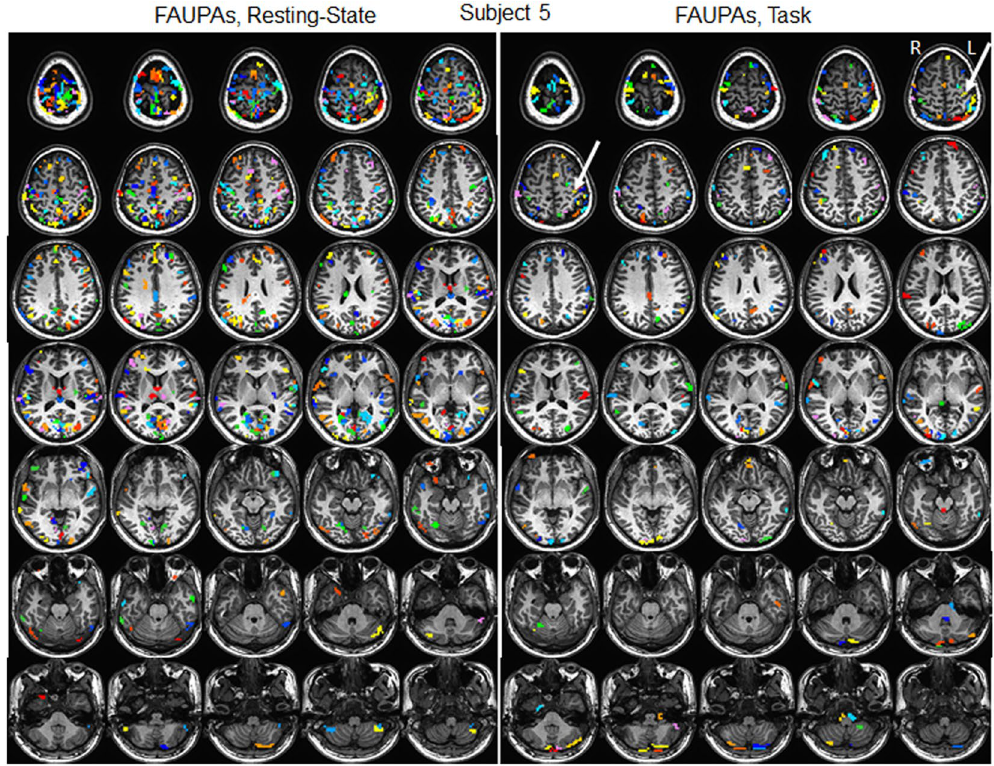
Figure 1. Illustration of FAUPAs for subject 5 (Table 1). Each colored cluster with all connected voxels of the same color represents a FAUPA, and a total of 16 colors are used to differentiate these FAUPAs. Resting State: a total of 433 FAUPAs; Task: a total of 203 FAUPAs. The arrow-pointed yellow-colored cluster on the left primary motor cortex illustrates a FT-associated FAUPA, i.e, its signal change time course appears to be associated with the FT task (Fig. 3). L: left; R: